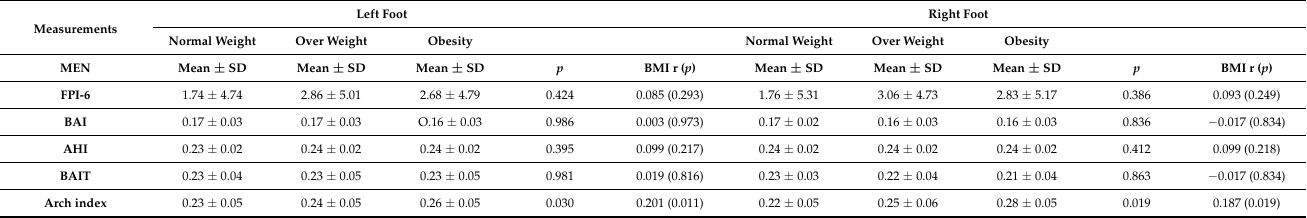
Table A5. Differences in medial longitudinal arch morphology according to body mass